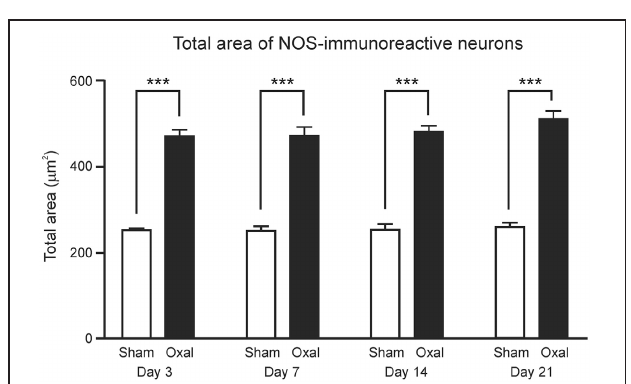
FIGURE 4 | Effects of repeated in vivo oxaliplatin administration on the total area of NOS-IR neurons ( μ m 2 ) within the myenteric plexus of the distal colon segments. Data represent the mean ± SEM. A significant increase in the total area of neurons immunoreactive to NOS was observed at all four time points (Day 3, 7, 14, and 21), following oxaliplatin administration in comparison to the sham-treated mice ( ∗∗∗ P < 0 .